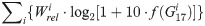
The mutational effects in the laboratory drift correlate with sequence exchanges in M.HaeIII orthologs.
a. The positional rates of evolution in M.HaeIII’s natural orthologs (‘Rate4site’, μ; red line) were plotted alongside the positional W
rel values in M.HaeIII (blue line). The positional W
rel values correspond to the average W
rel values for all mutations in this position (∑i{Wreli⋅log2[1+10⋅f(G17i)]}, Where i refers to all the possible single nucleotide mutations at a given residue position. Upper panel–positions 2 to 175; Lower panel–positions 176 to 330. Noted are M.HaeIII’s key functional residues, those of the cofactor binding site, the catalytic residues including the enzyme’s reaction center (Cys71, black arrow), and the target DNA binding residues. Also noted are positions of compensatory mutations that were enriched in the drift W
rel > 1.1, listed in S2 Table). b. M.HaeIII’s three-dimensional structure illustrated as a cartoon (PDB id 1dct). Residues are colored from blue to red according to their averaged W
rel values (as in c). The cofactor, SAM, is in yellow, and the enzyme’s catalytic residue (Cys71) is in green. c. The same as b for the positional diversity calculated by Rate4site (μ, as in c) [65]. d. The distribution of PROVEAN scores for all possible single nucleotide missense mutations (n = 1,957). Shown are the distribution of mutations categorized as ‘deleterious’ (W
rel ≤0.6), and of mutations categorized as ‘nearly-neutral’, ‘neutral’ and ‘beneficial’ (W
rel >0.6). e. The same distribution while excluding ‘nearly-neutral’ mutations.